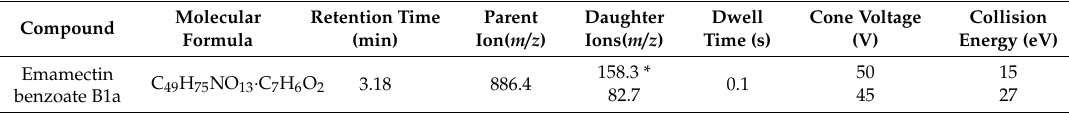
Table 5. ESI + MS / MS parameters for the determination of emamectin benzoate B1a.